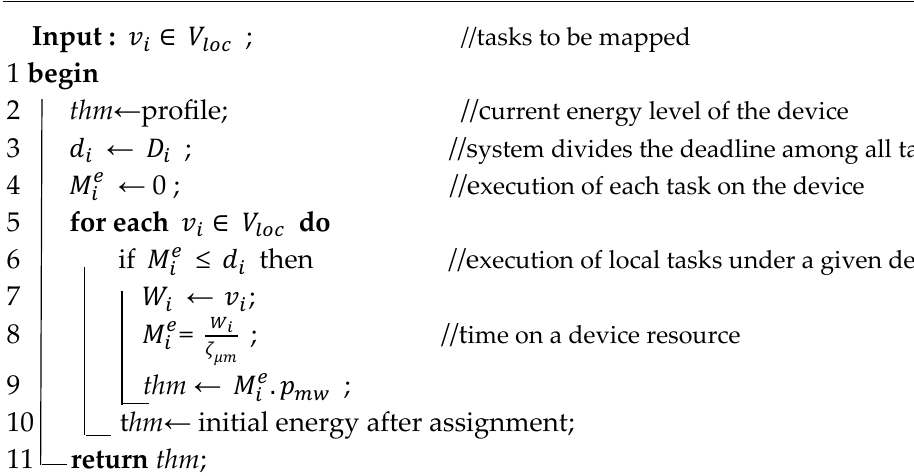
Algorithm 2: Local Task Assignment